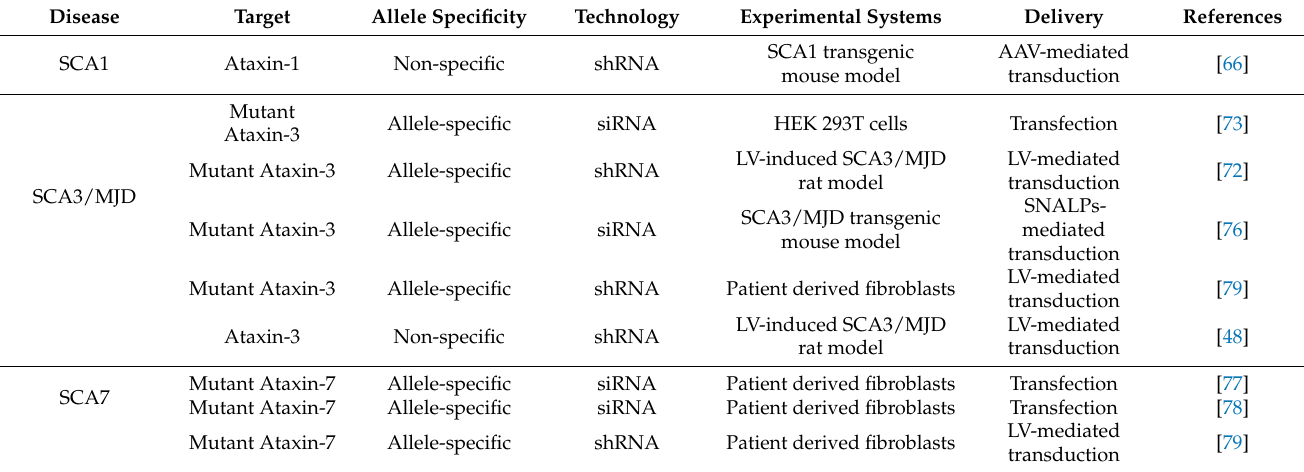
Table 4. Selected siRNA and ShRNA based studies in polyglutamine spinocerebellar ataxias.